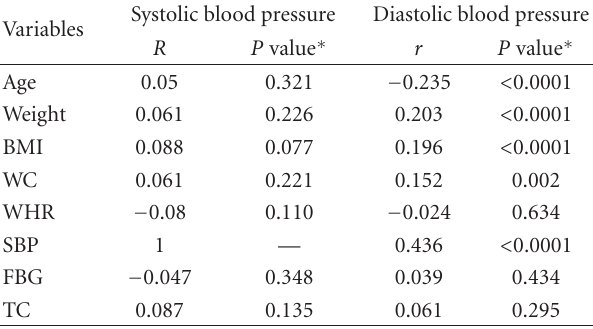
Table 3: Pearson’s correlation analysis of SBP and DBP with some clinical characteristics.